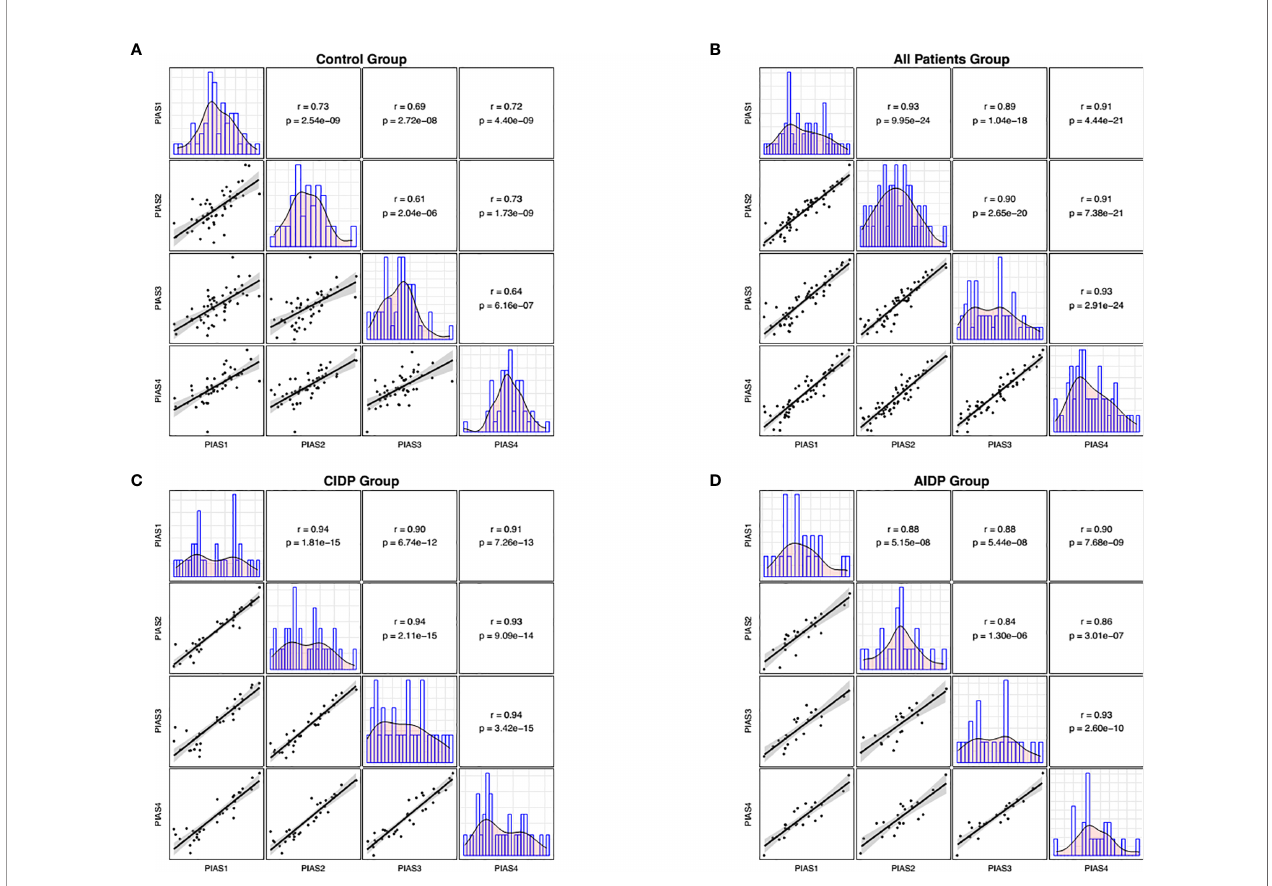
FIGURE 2 | Correlations between transcript quantities of PIAS genes. The distributions of parameters are represented on the diagonals. The bivariate scatter plots with a fi tted line are shown on the lower parts of the diagonals. Correlation coef fi cients and p values of the correlations are displayed on the upper sections of the